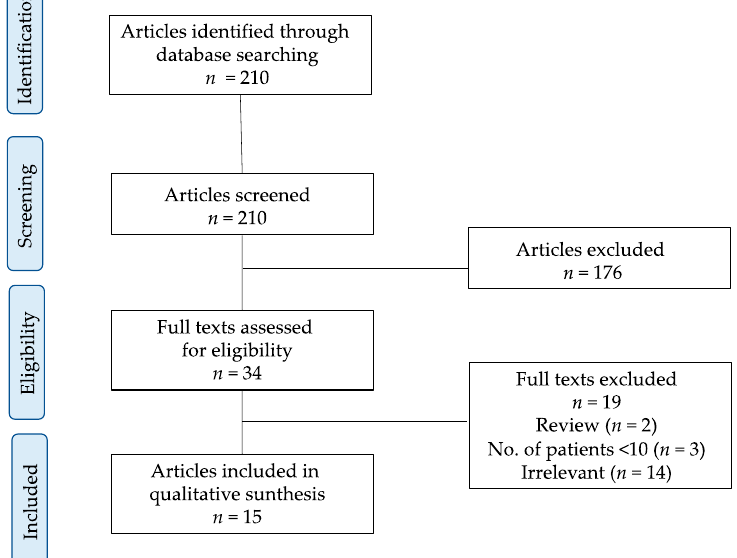
/ D vs. EPP” and “P / D vs.